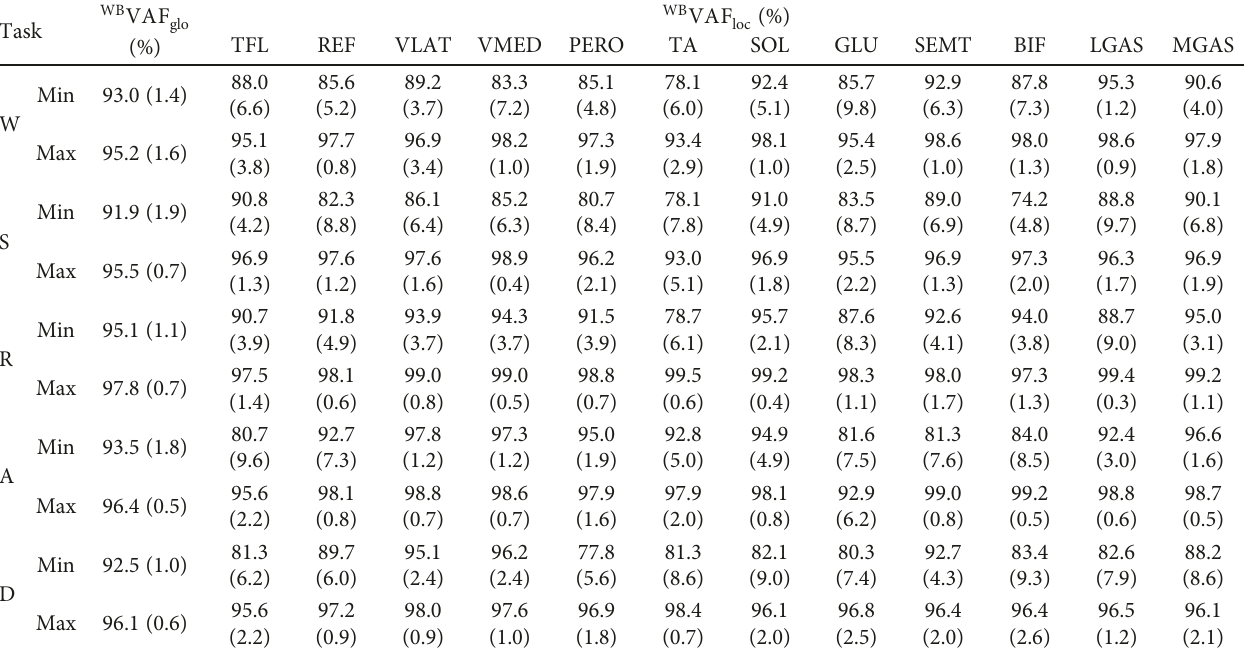
and WB VAF related to each task. glo loc